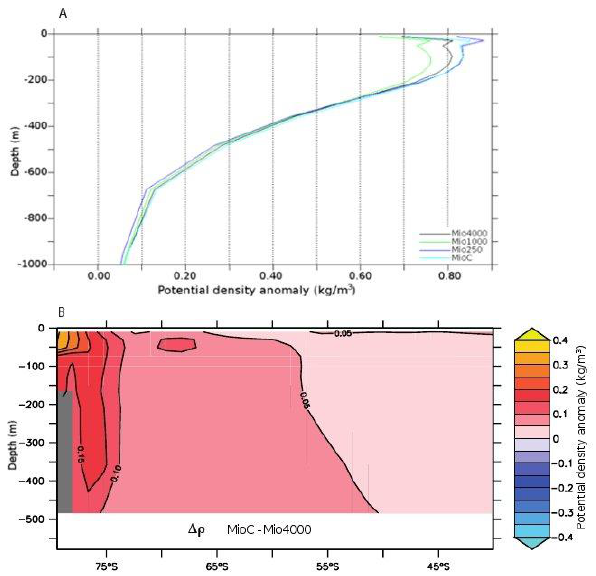
Fig. 10. (A) Simulated potential density (kgm − 3 − 1000) anomaly between a southern box (70–55 ◦ S) and a northern box (55–35 ◦ S) in the Indian Ocean (40–75 ◦ E), as a function of depth. (B) Sim- ulated potential density anomaly (kgm − 3 ) between MioC and Mio4000 in the Indian Ocean.